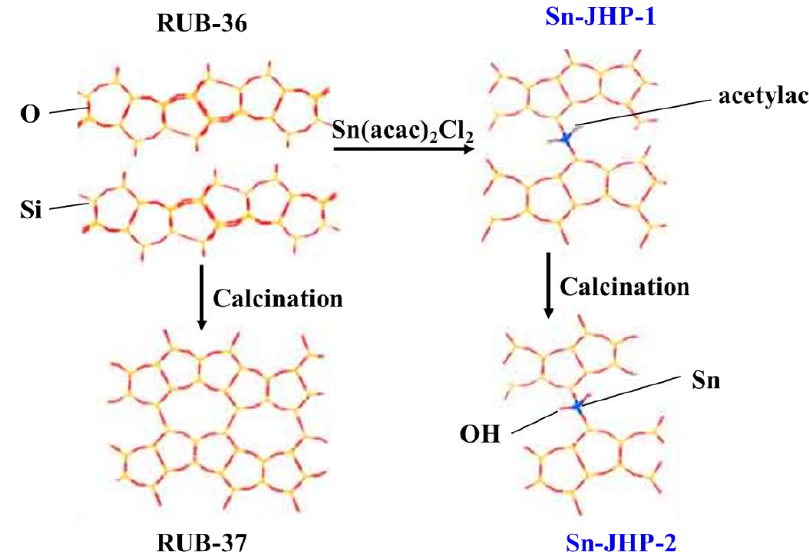
Figure 1. Schematic diagram of topological conversion of layered RUB-36 to RUB-37, Sn-JHP-1 and Sn-JHP-2.